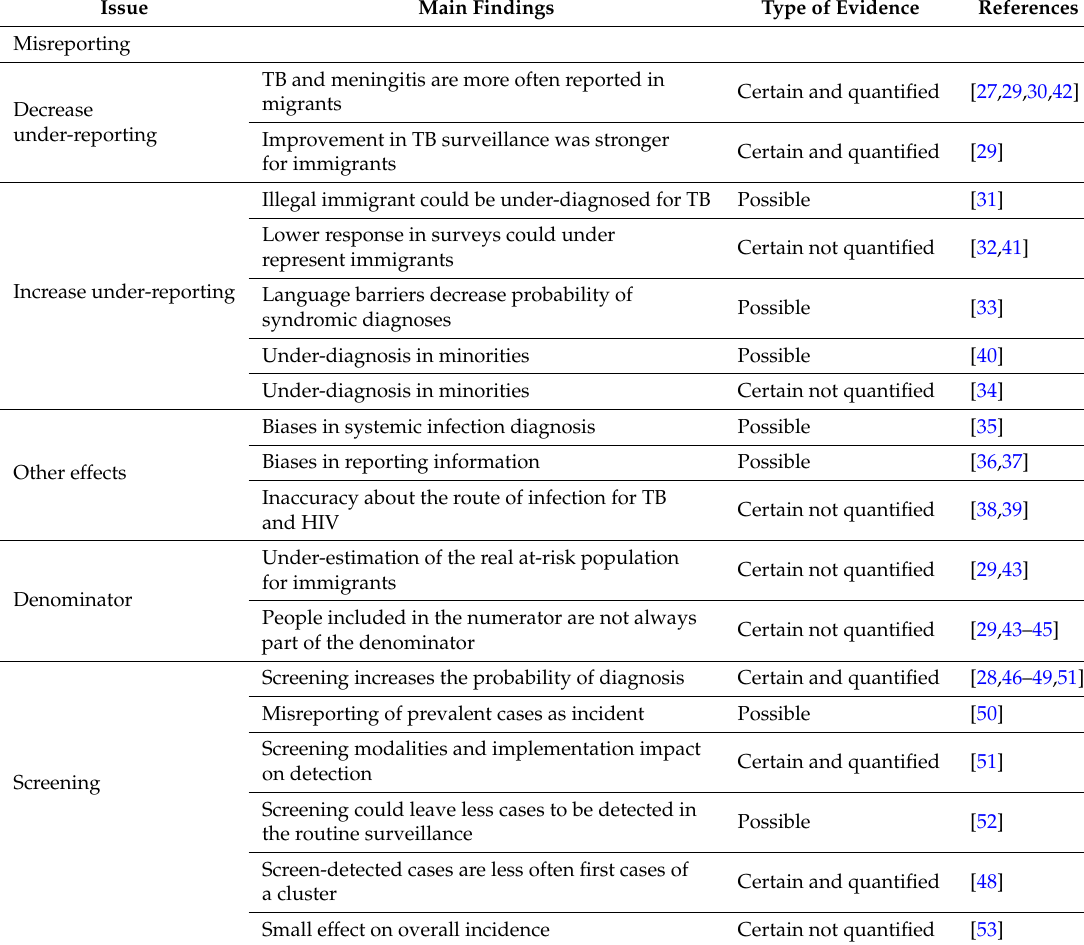
Table 1. Summary of